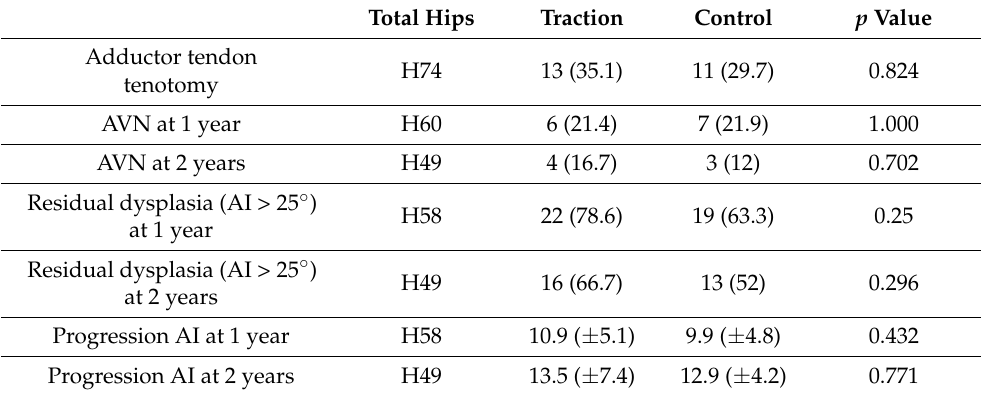
Table 3. Secondary outcomes for adductor tendon tenotomy, AVN, and residual